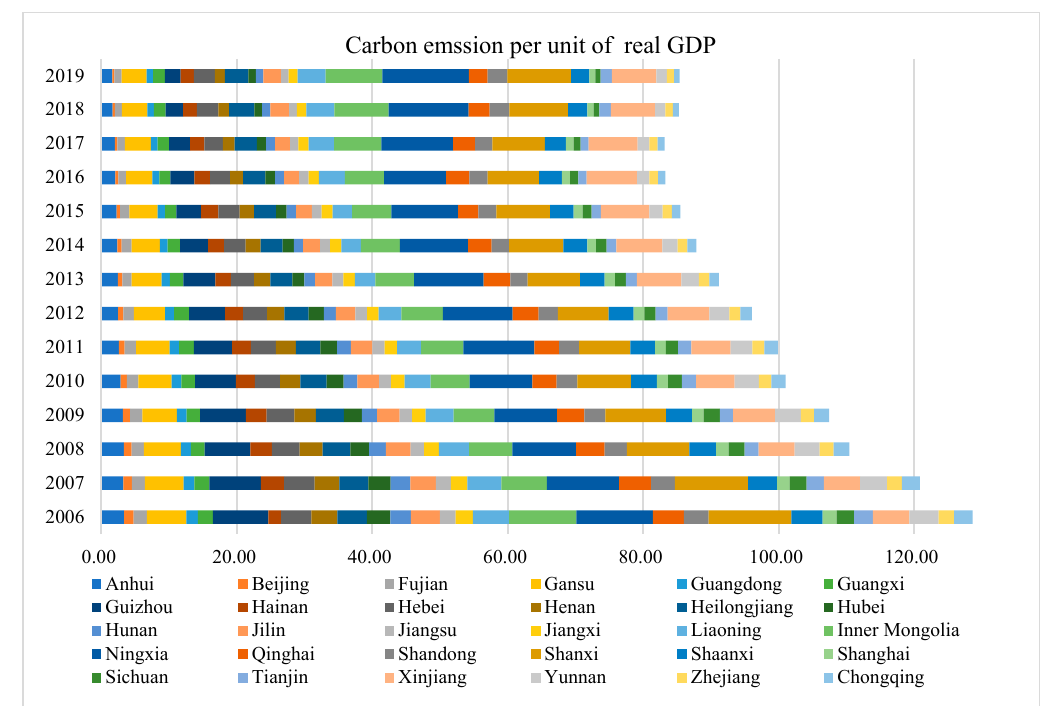
Figure 2. Provincial carbon intensity from 2006 to 2019.